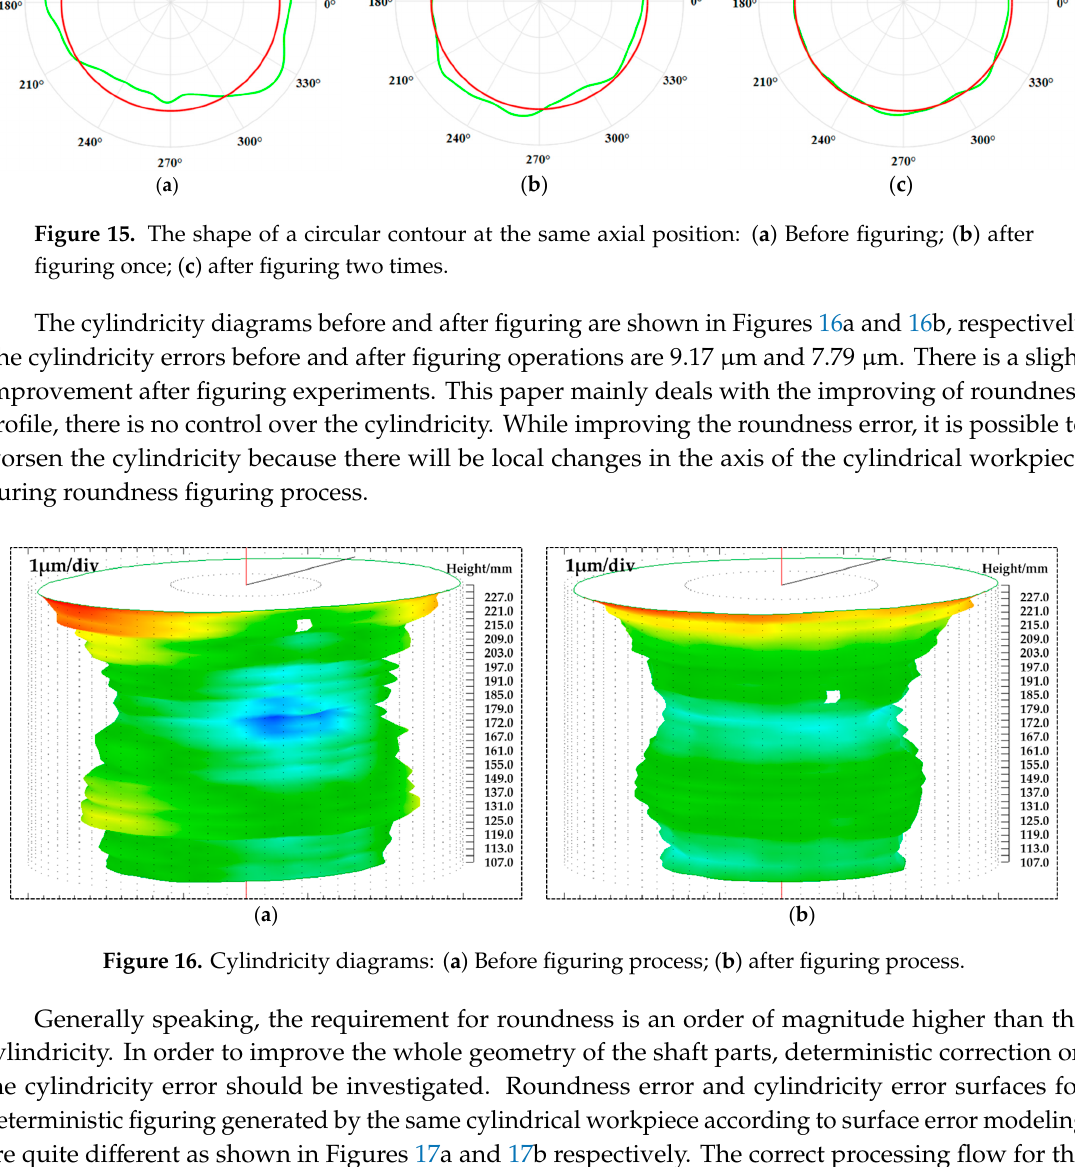
Figure 15. The shape of a circular contour at the same axial position: ( a ) Before figuring; ( b ) after figuring once; ( c ) after figuring two times.